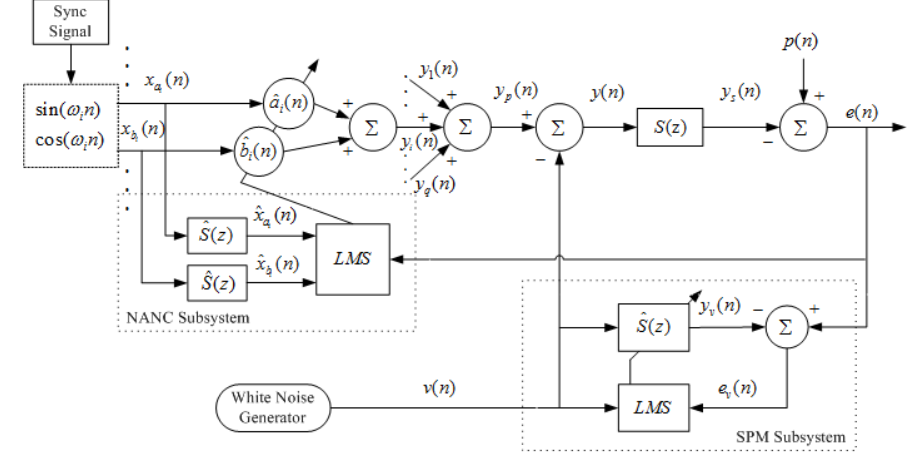
Figure 1. Narrowband active noise control (NANC) system with online secondary path modeling (SPM, i th